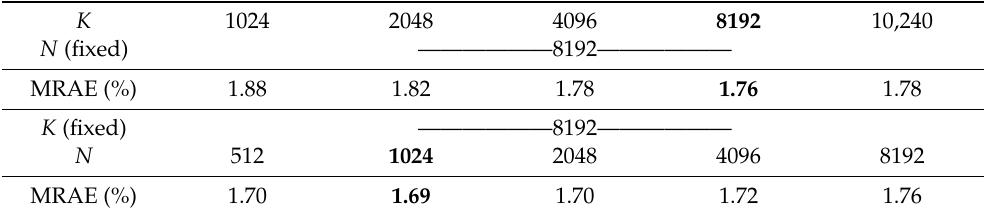
Table 3. The mean per-image-mean-MRAE performance in relation to the number of clusters ( K ) and the size of each cluster ( N ) used in our A++ method. The best result for each factor (while the other factor is fixed) is shown in bold